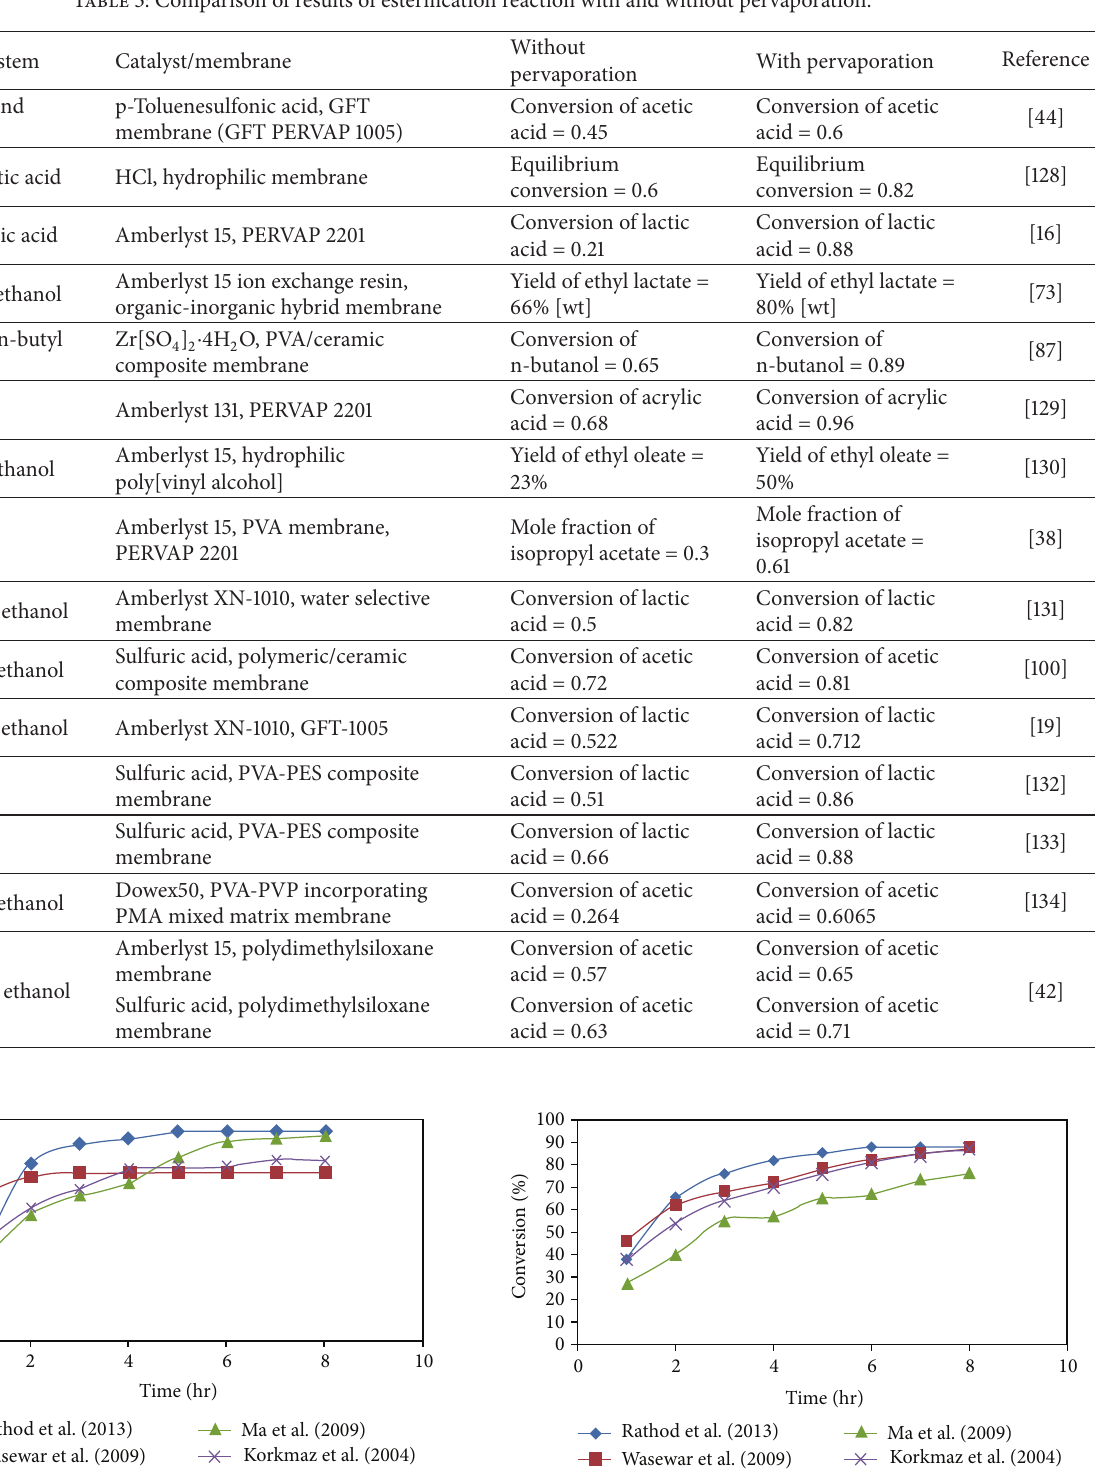
Figure 8: Different trends of conversion of acid with time for esterification with pervaporation